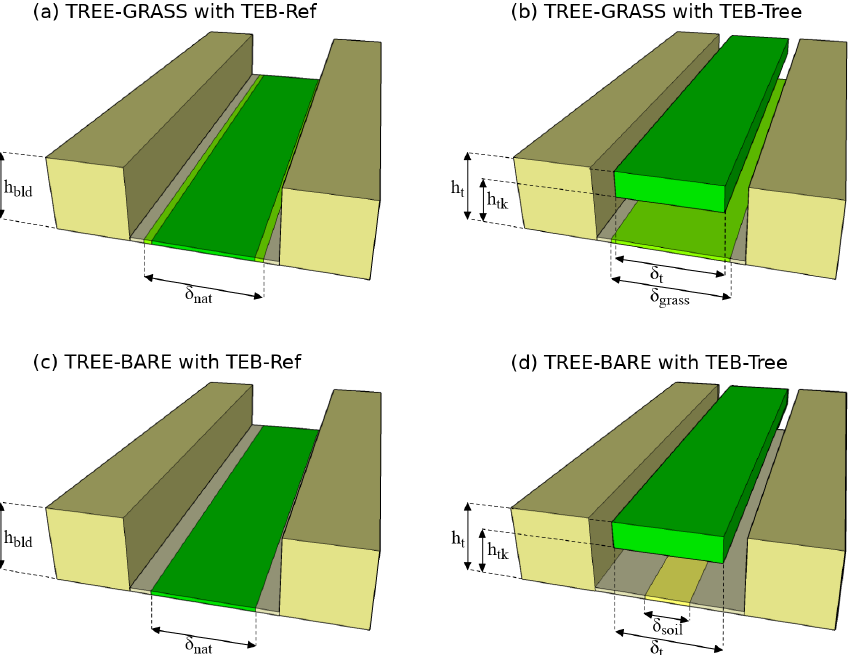
Figure 2. Comparison of urban canyon characteristics prescribed by TEB-Ref (a, c) and TEB-Tree (b, d) versions for the experiments TREE-GRASS (a, b) and TREE-BARE (c, d) . Table 2. Mean absolute error (MBE; model minus observations, Obs) and root-mean-square error (RMSE) in temperature, humidity, wind speed at 1.5ma.g.l., surface temperatures of walls and tree foliage, and in evaporation. The scores are calculated for TEB-Ref, TEB-Tree, and for the two courtyard configurations TREE-GRASS and